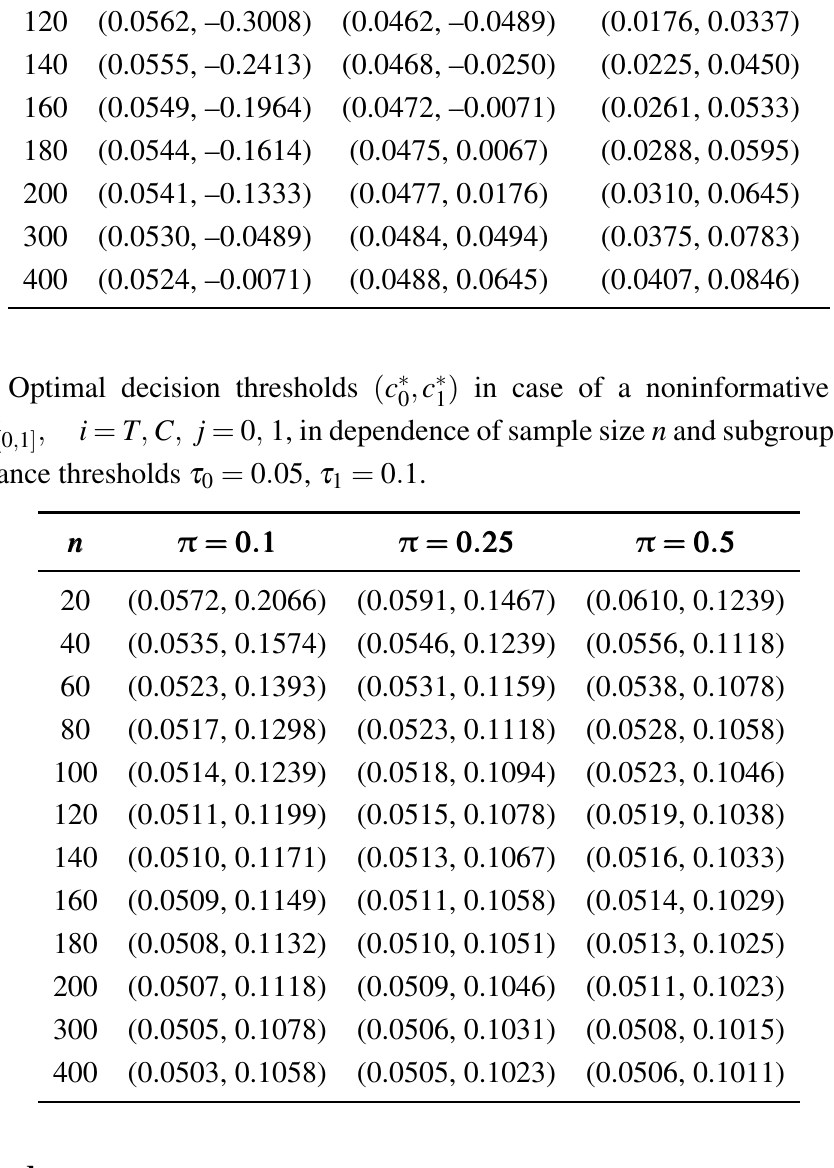
Table 2. Optimal decision thresholds ( c (cid:3)